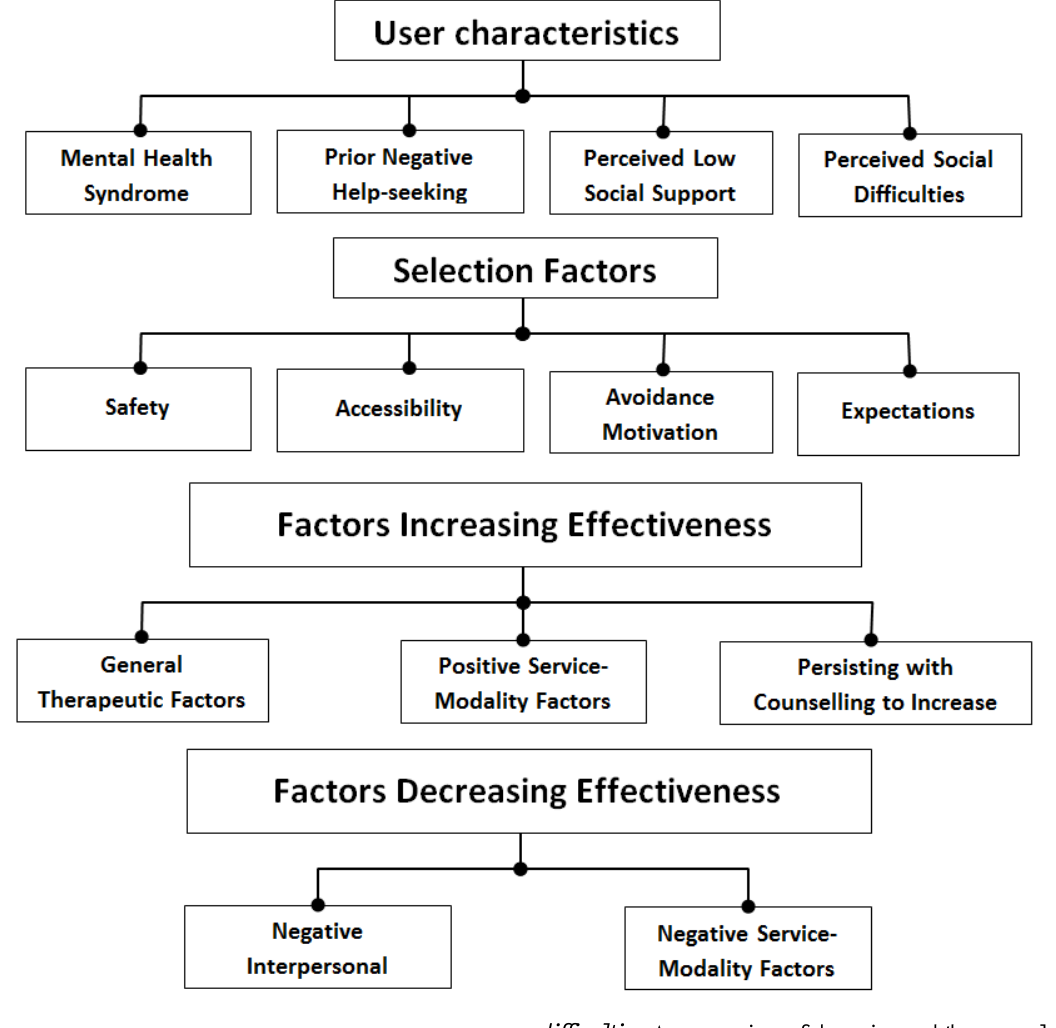
Figure 1. Overview of primary domains and themes identified by text-based online counseling